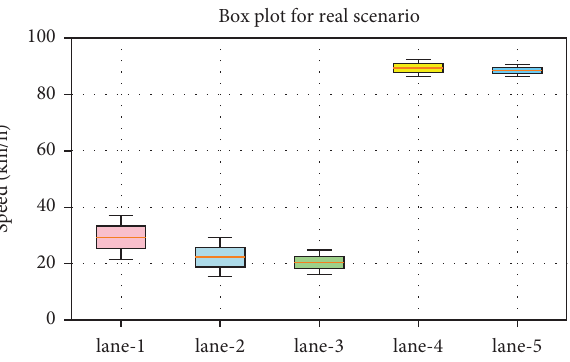
Figure 4: Distributions of average vehicle speeds in the weaving